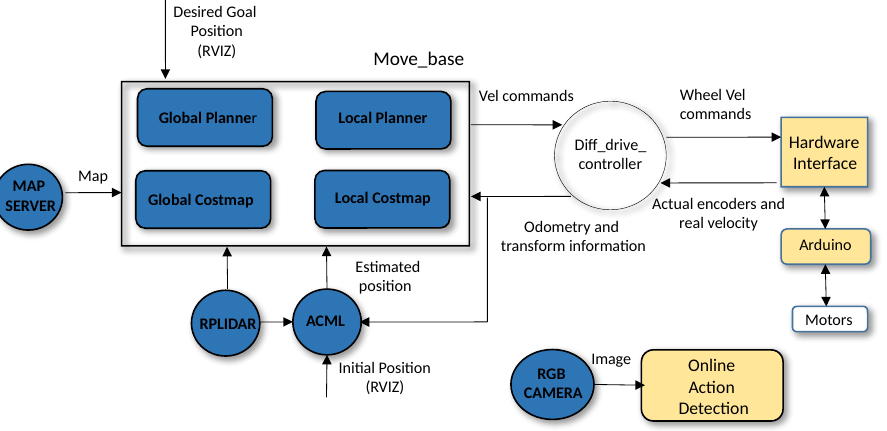
Figure 3. ROS Melodic architecture embedded in LOLA2 platform. Blue nodes represent distributed software ROS packages and yellow nodes are those ROS nodes entirely developed by us to integrate ROS in our